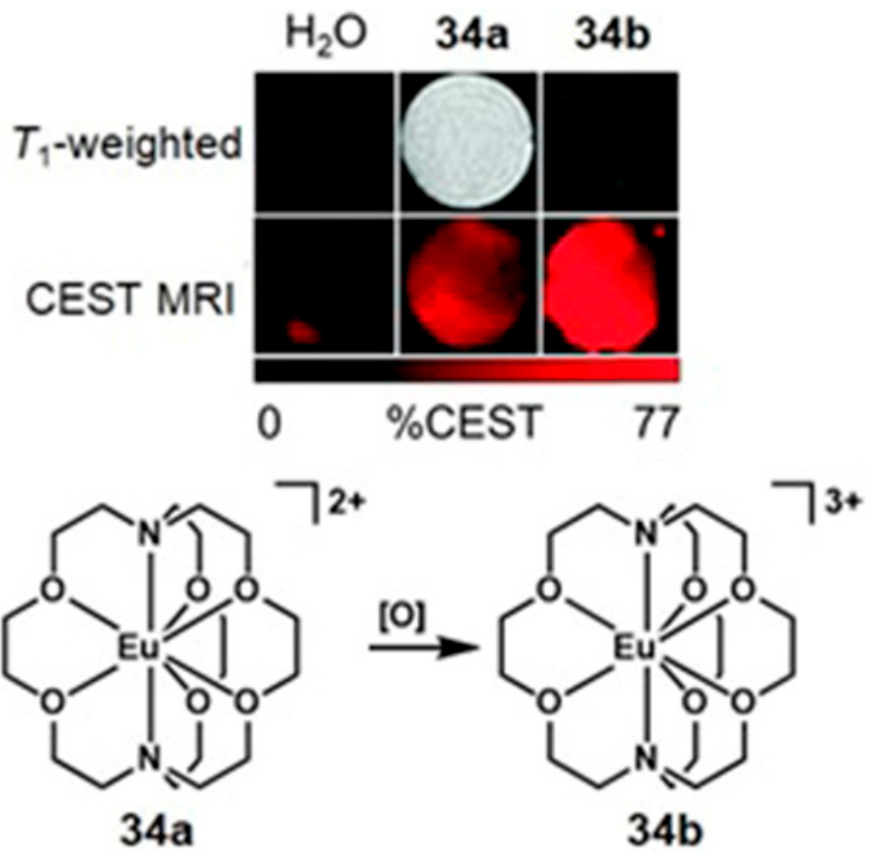
Figure 68. (Left to right) MR images of water, Eu II -containing liposomes, Eu III -containing liposomes (5 mm tube diameter, at 7 T and 24 ◦ C). T 1 -weighted images ( top row ) and CEST map generated by subtracting presaturation at 1.2 ppm from presaturation at –1.2 ppm and the difference was divided by presaturation at –1.2 ppm ( bottom row ). %CEST represents the decrease in bulk water signal intensity as a result of presaturation of exchangeable water protons associated with liposomes. Adapted with permission of the Royal Society of Chemistry from Oxidation-responsive Eu 2+/3+ -lip- osomal contrast agent for dual-mode magnetic resonance imaging, Ekanger, L. A.; Ali, M. M.; Allen,